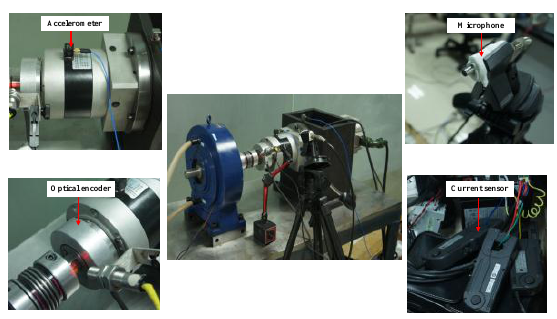
Figure 5. Four types of sensors and their installations.